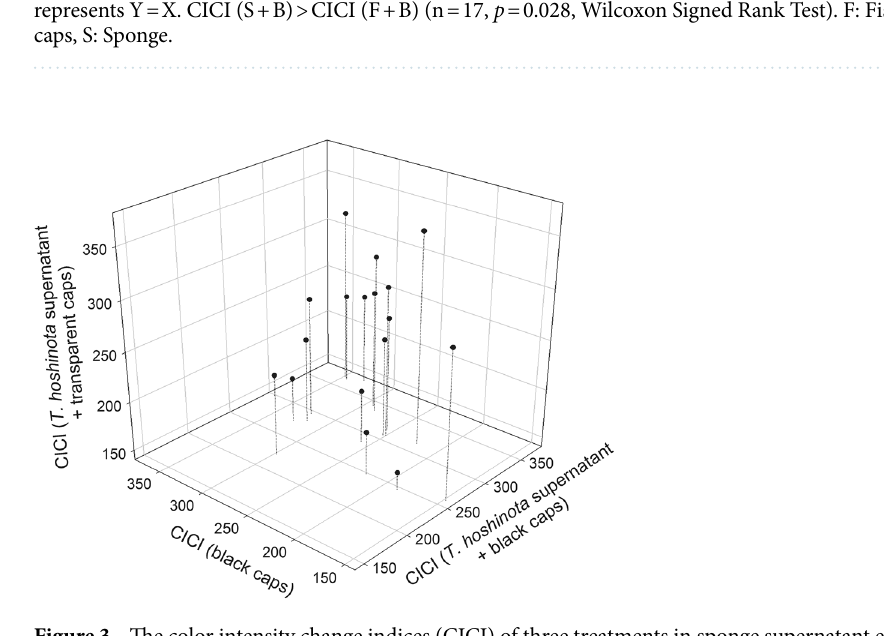
Figure 3. The color intensity change indices (CICI) of three treatments in sponge supernatant experiment. CICI (S + B) > CICI (B) = CICI ( S ) (n = 19, “S + B” vs. “B”: p = 0.055; “S + B” vs. “S”: p < 0.01; “B” vs. “S”: p = 0.12, Wilcoxon Signed Rank Test,). S: Sponge, B: